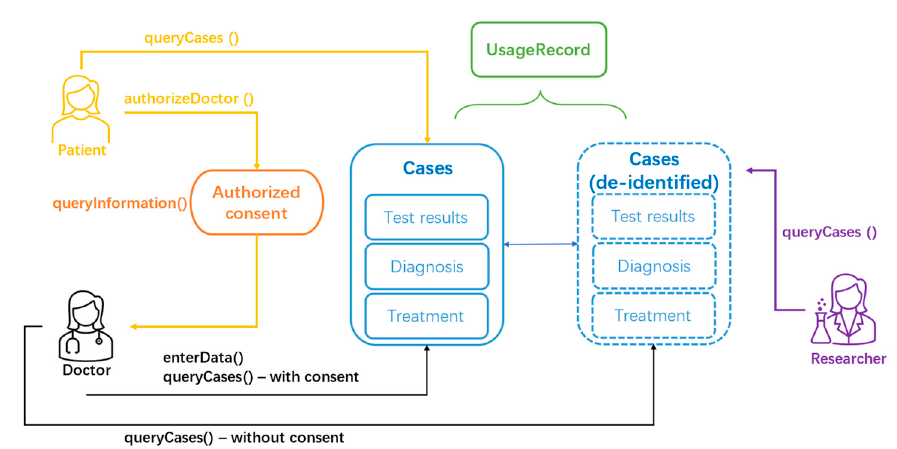
Figure 7. System function modules interactions. Table 3. Functions in the smart contract.